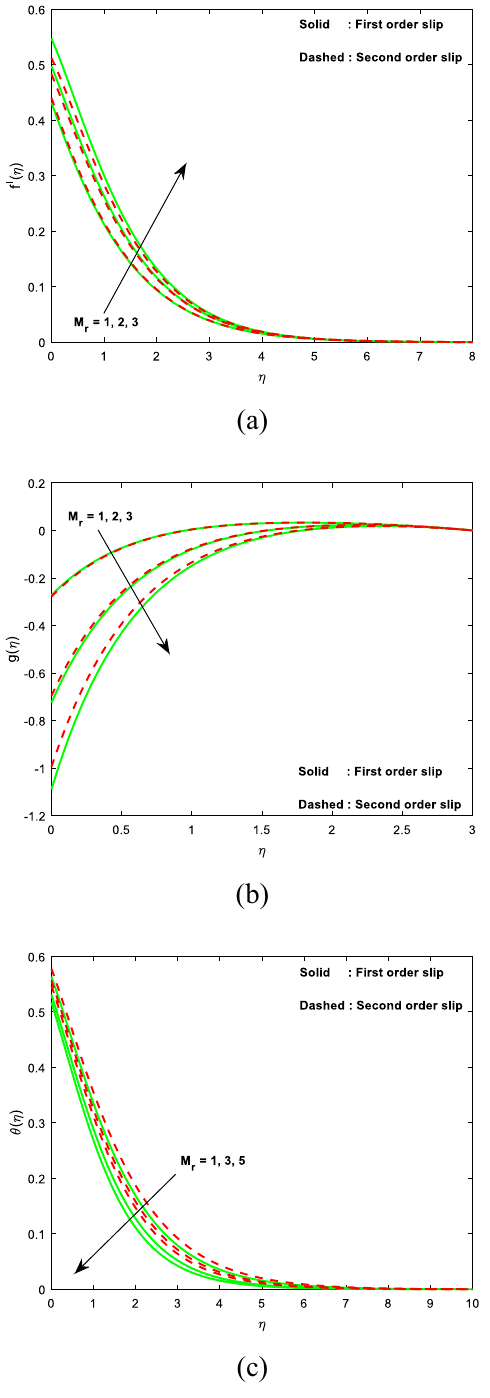
Figure 5. Impact of M r on ( a ) velocity ( b ) microrotation ( c )